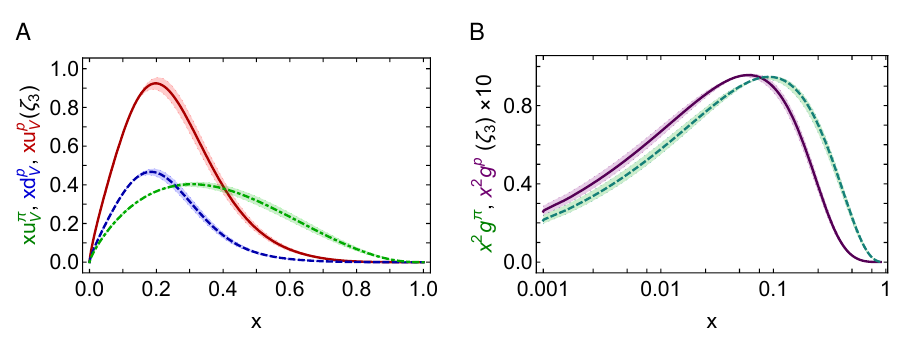
Figure 4. Distribution functions. A –valence quark DFs in the proton ( u quark, solid red; d -quark, dashed blue) and pion (dashed green); B –glue DFs in the proton (solid purple) and pion (dashed green). In each case, the like coloured band expresses the response to a ± 5% variation in ζ H